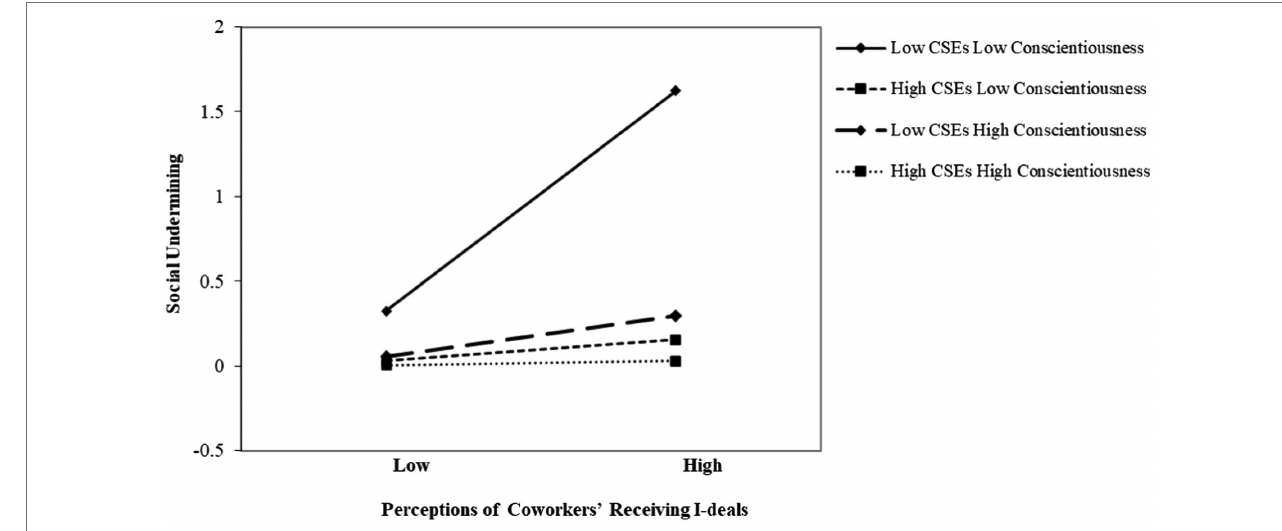
FIGURE 4 | Moderated indirect effect of perceptions of coworkers’ receiving i-deals on social undermining ( via relative deprivation) at low and high levels of CSEs and